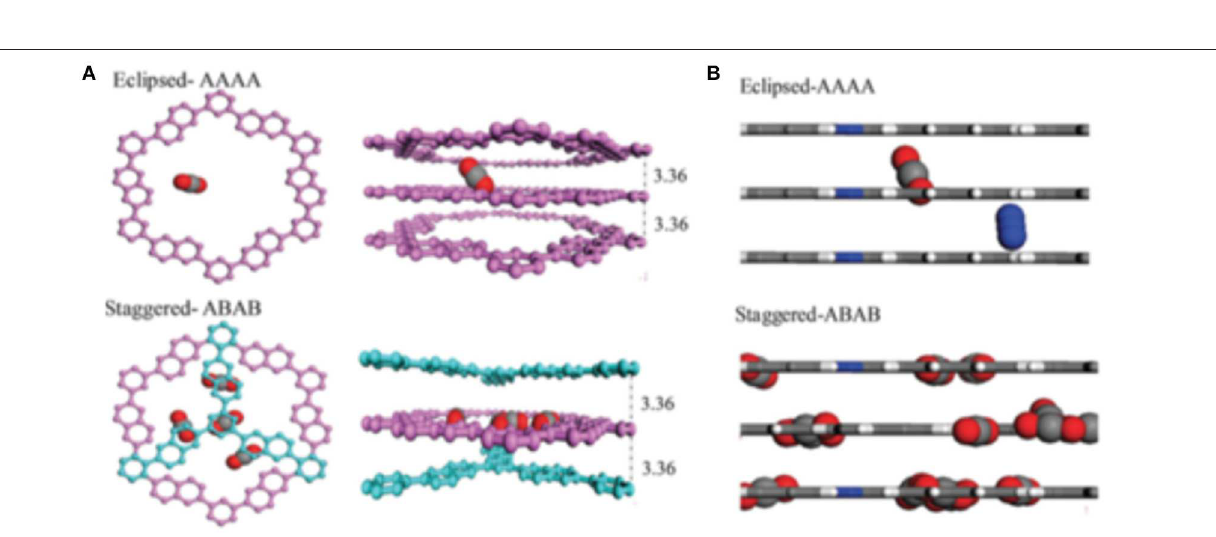
Babarao and Jiang (2008) for the relation between N gra ex and N vol with V free are shown below (3,